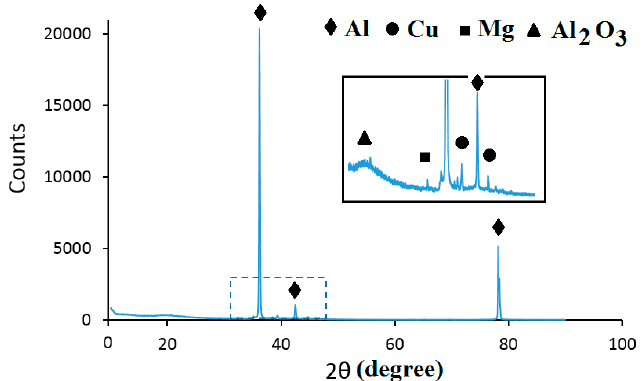
Figure 16. XRD spectrum of the fracture surface for joints bonded with Cu/Al 2 O 3 for 2 min.